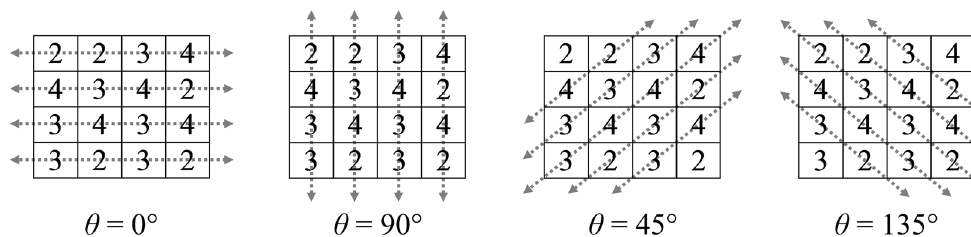
Figure 2. Common scanning directions for generating a GLCM.